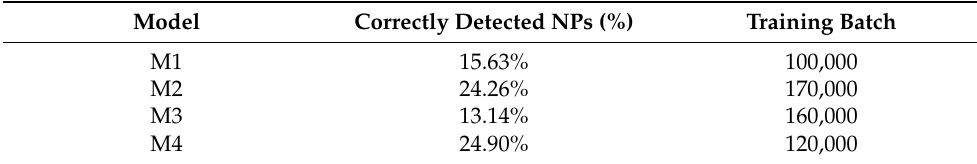
Table 6. Detection results for all models on the validation Dataset II.